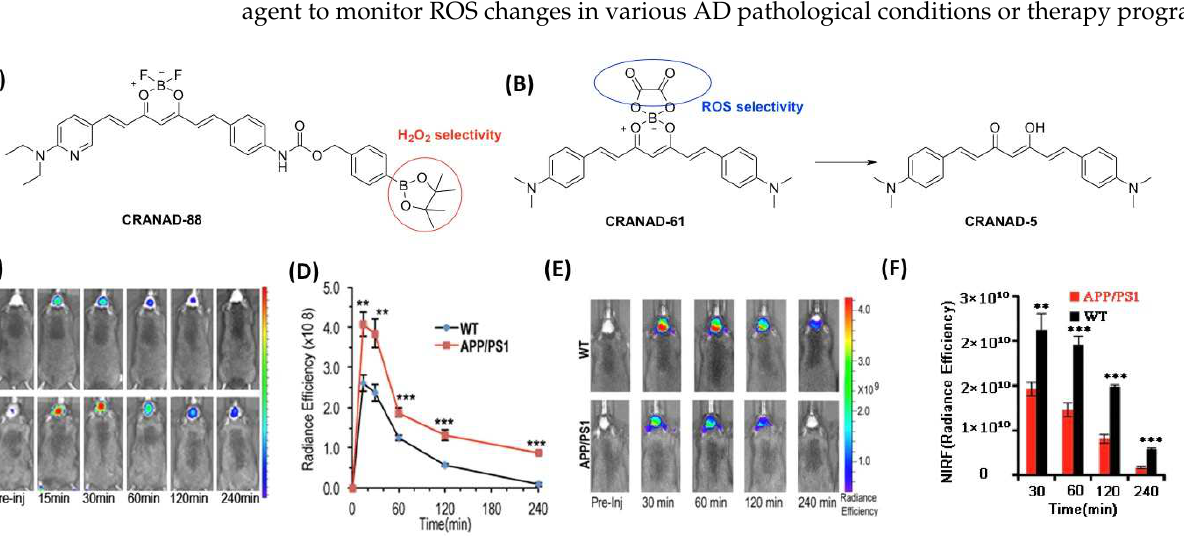
Figure 8. ( A ) The chemical structure of CRANAD-88; ( B ) The reaction of CRANAD-61 with ROS; ( C , E ) Representative images of APP/PS1 and WT mice after i.v. injection at different time points, reprinted with permission from [61] . Copyright 2016 Springer. ( D , F ) Fluorescence intensity of CRANAD-88 and 61 between APP/PS1 and WT mice in brain area. ** p < 0.01, *** p < 0.005. Reprinted with permission from [62] . Copyright 2017 PNAS.